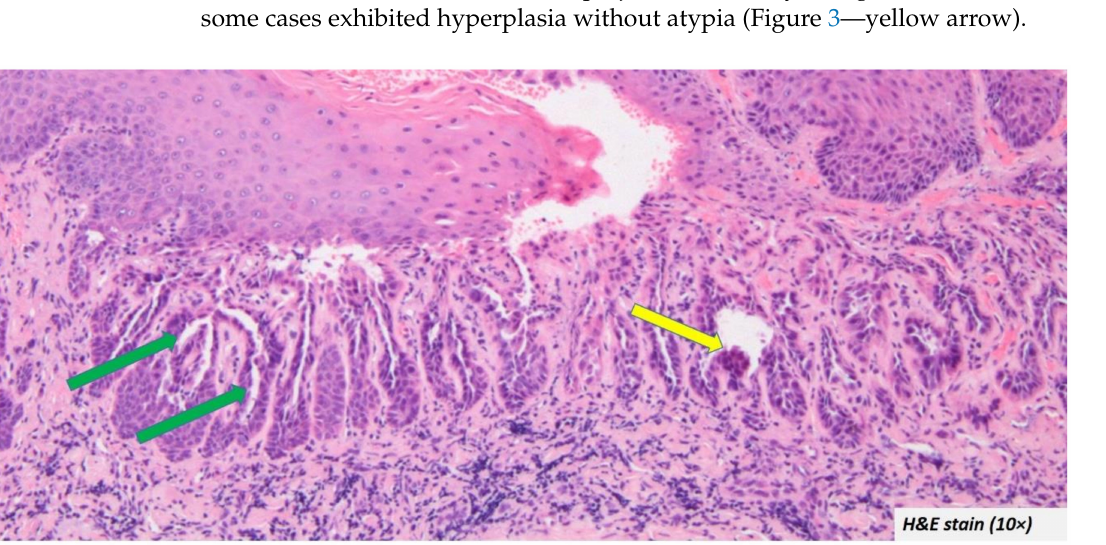
Figure 3. Most oral warty dyskeratoma cases included in the systematic review showed intra epithelial clefting at the supra-basal region (green arrow) and the cleft was lined by hyperplastic basal cells (yellow